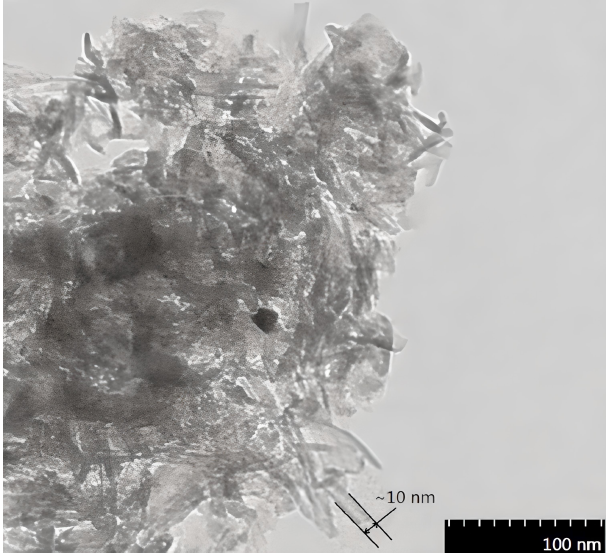
Figure 5. Images of 550 ◦ C calcined Zn 2 + -doped transmission electron micrographs (TEM), reprinted with permission from Ref. [54]. Korean Society of Environmental Engineers,